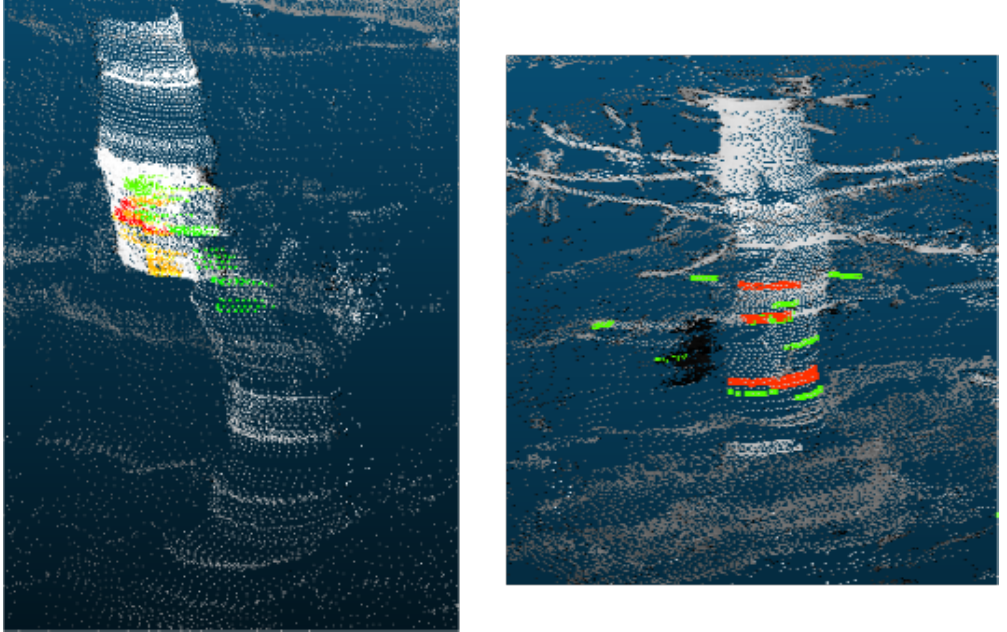
Figure 14. Example of error sources. Green-yellow points are all clustered points; red points are used for DBH estimation. Left: 0.27 × DBH Field underestimation. Errors in the trajectory have curved and clipped the stem. Right: 1.85 × DBH Field overestimation of a spruce with many twigs disrupting the clustering process. Only few clusters have been made, and just four of them have been used for the